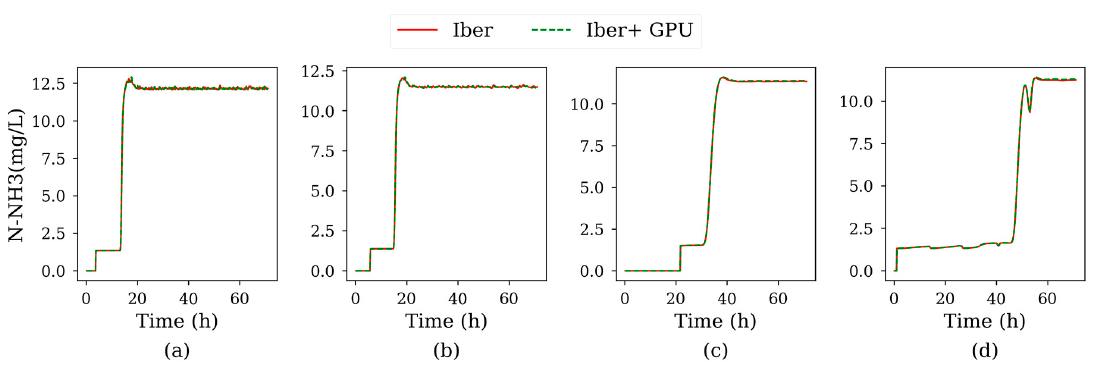
Figure A12. Time series of ammoniacal nitrogen for Test 4, sampled at control points P1 ( a ), P2 ( b ), P3 ( c ) and P4 ( d ).